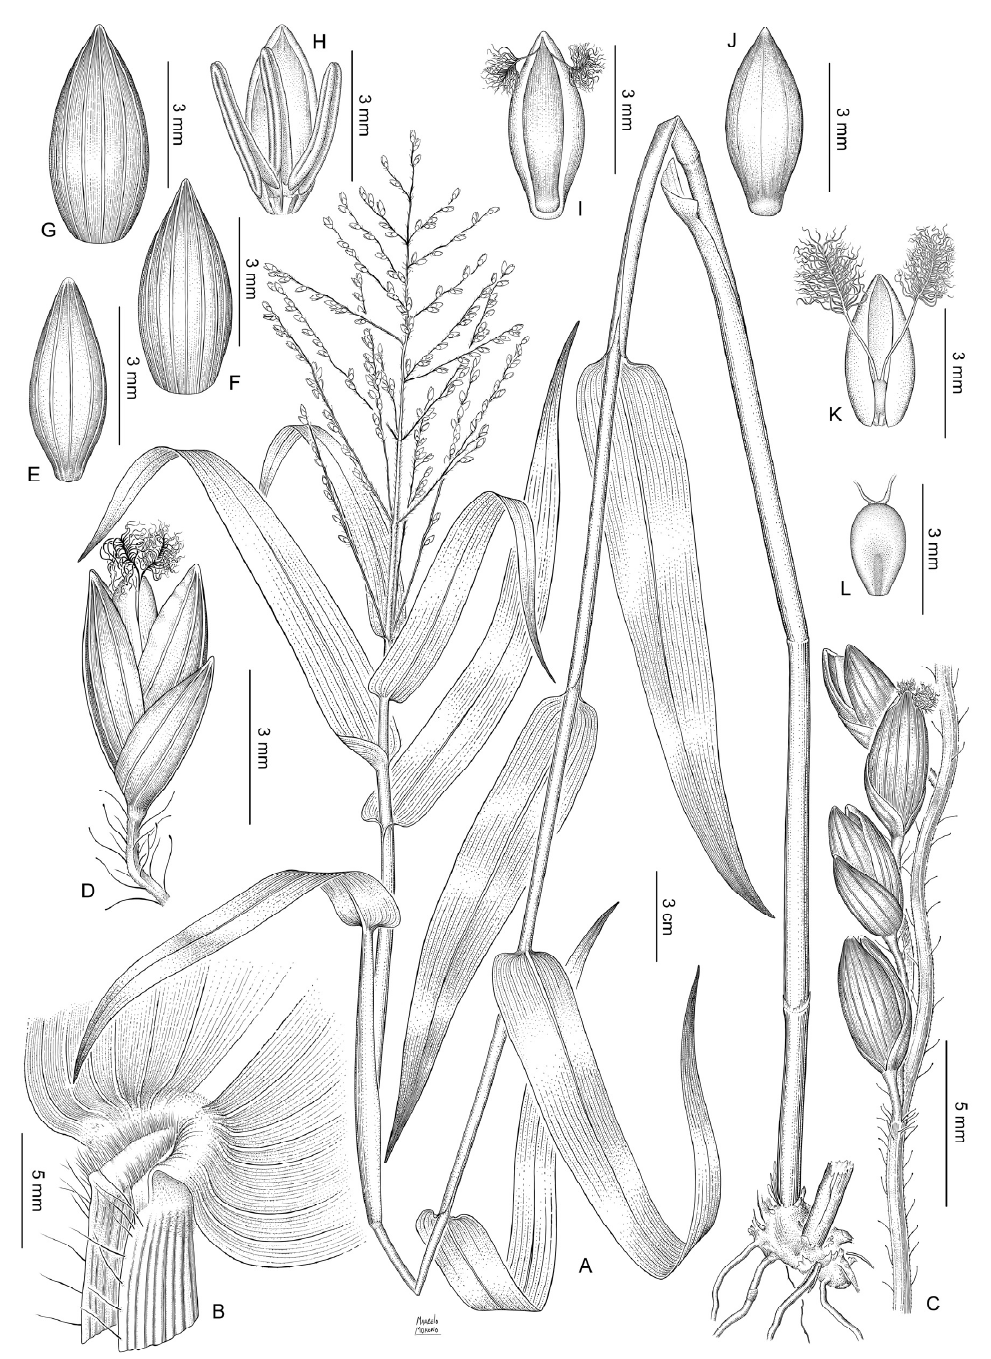
Figure 4. Batochloa deusta (Thunb.) Salariato & Zuloaga: ( A ). habit; ( B ). ligular region; ( C ). portion of the inflorescence with clavellate hairs; ( D ). spikelet, lateral view and pedicel with clavellate hairs; ( E ). lower glume, dorsal view; ( F ). upper glume, dorsal view; ( G ). lower lemma, dorsal view; ( H ). lower palea and lower flower with three stamens; ( I ). upper anthecium, ventral view; ( J ). upper anthecium, dorsal view; ( K ). upper palea with lodicules and gynoecium; and ( L ). caryopsis, hilum view [voucher: ( A – L ): Bredo3398 ].